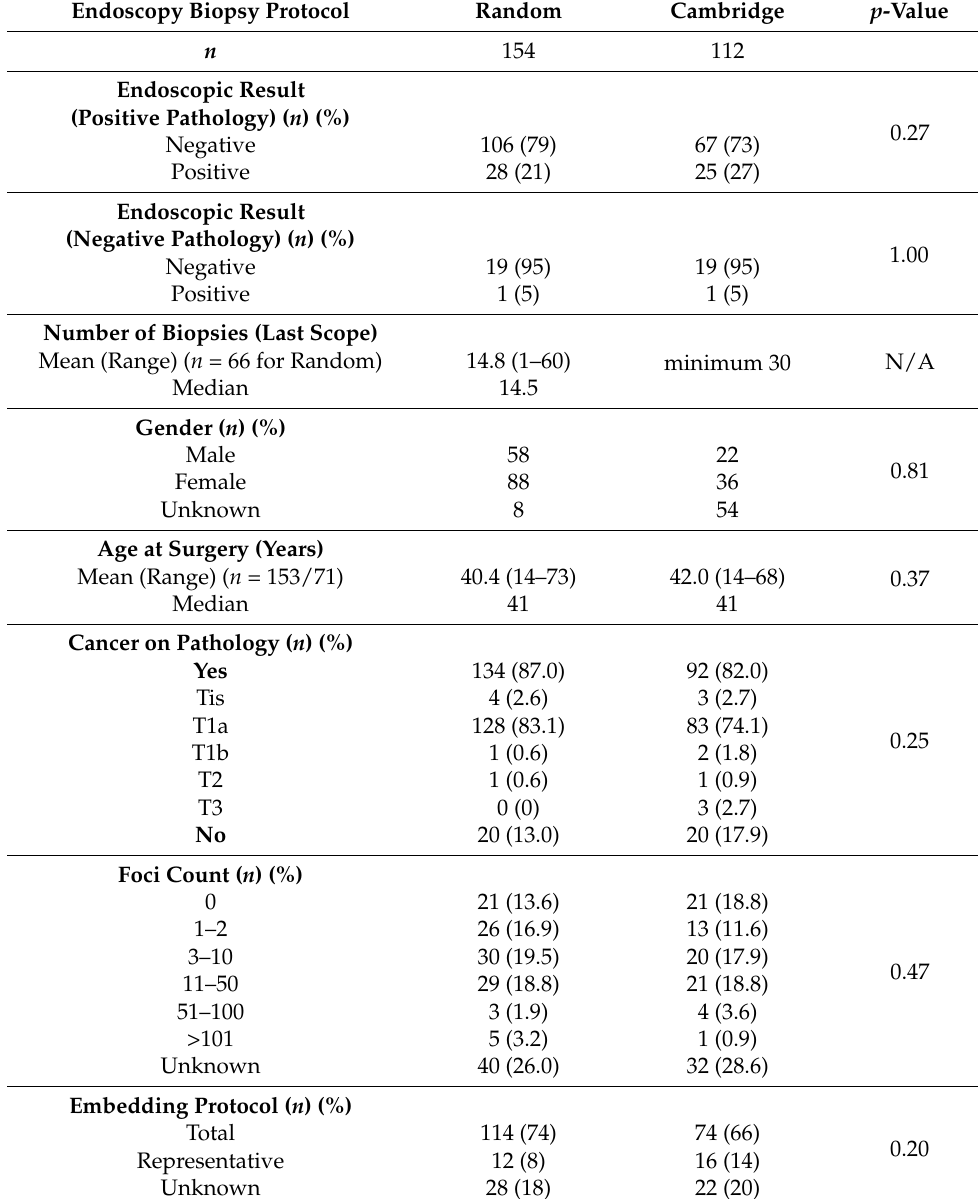
Table 4. Pooled results from systematic review comparing random biopsies to Cambridge Protocol biopsies in the surveillance of asymptomatic CDH1 mutation